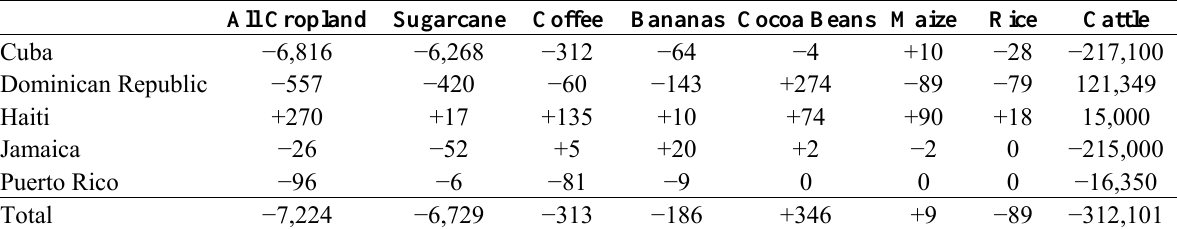
Table 5. Net change in crop area harvested (2001 to 2008/09) in km 2 and number of head of cattle (2001 to 2008). Data used to construct this figure was obtained from FAOSTATS [33]. All Cropland Sugarcane Coffee Bananas Cocoa Beans Maize Rice Cattle